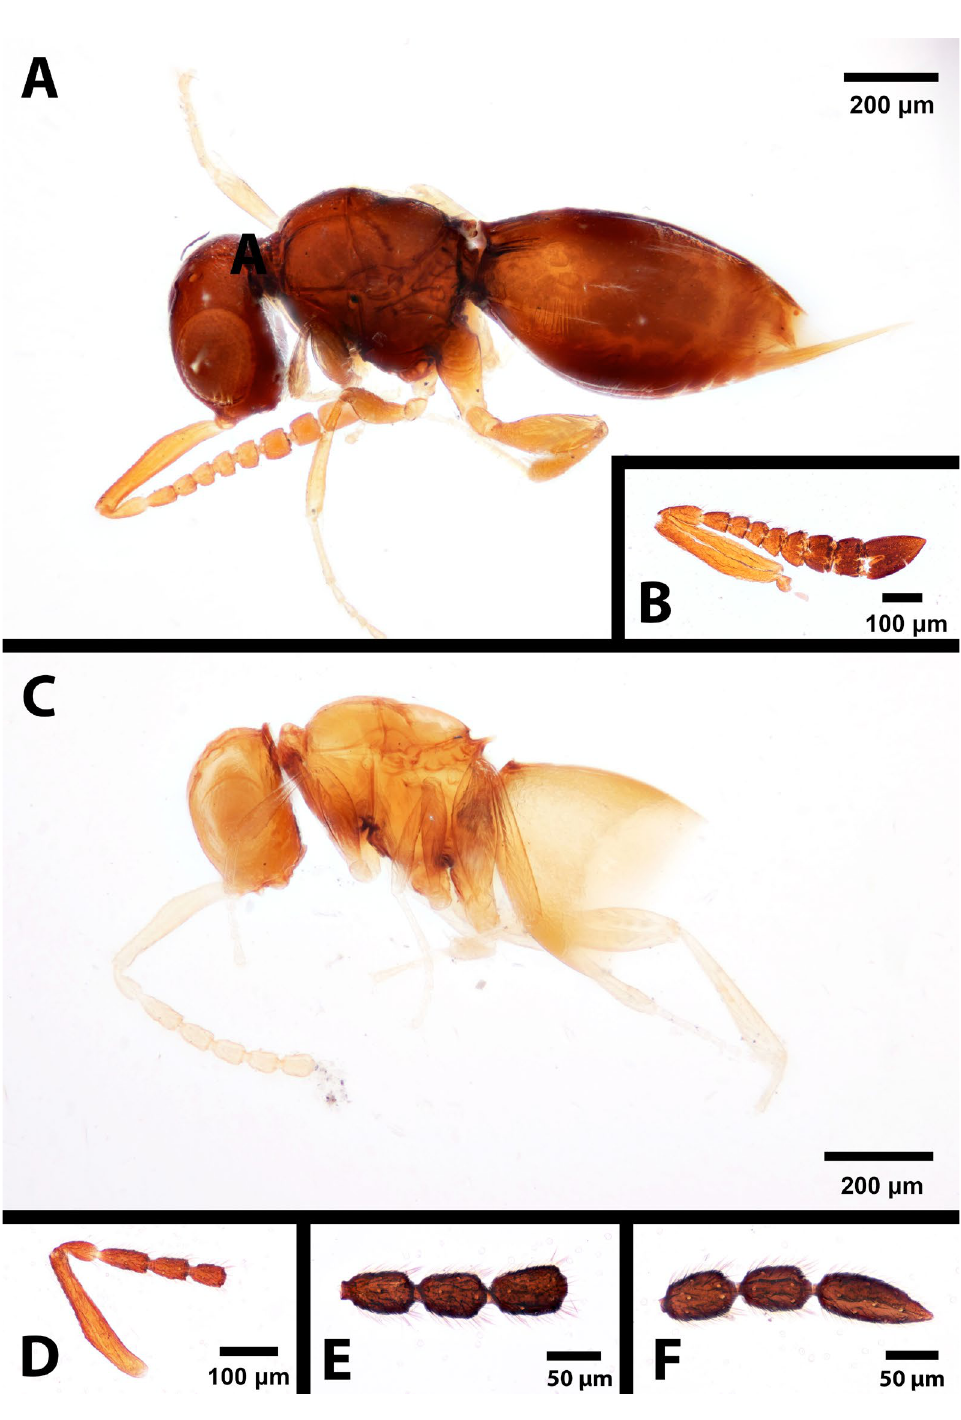
Fig. 15. Ceraphron parvalatus Dessart, 1966. A–B . Lectotype, ♀. A . Lateral view (MNhN EY25362). B . Antenna (MNhN EY22443). C . Allolectotype, ♂ (MNHN EY25363). D–F . Allolectotype, ♂ (MNHN EY22441). Antenna. D . Scape, pedicel and first three flagellomeres. E . F4–6. F .